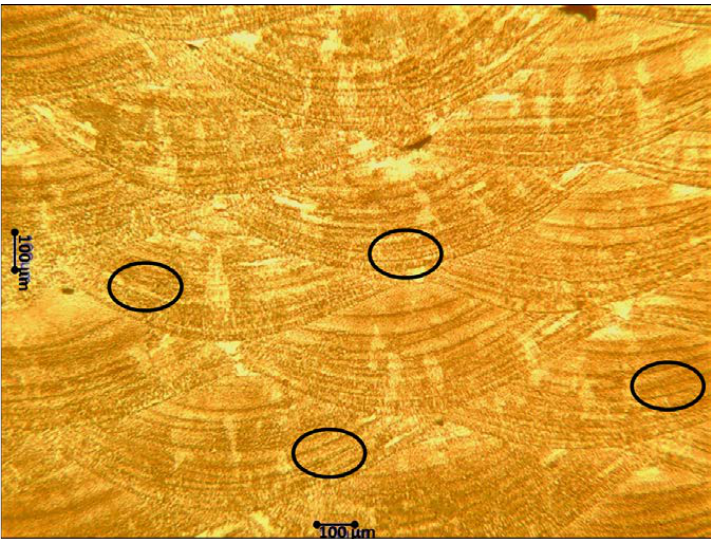
Figure 8. Multilayered build #7 (low P f :T s ), considerable re-melting which leads to microsegregation (black circles), and larger grains, Vickers: 213 ± 14. J. Manuf. Mater. Process. 2018 , 2 , x FOR PEER REVIEW 11 of 14